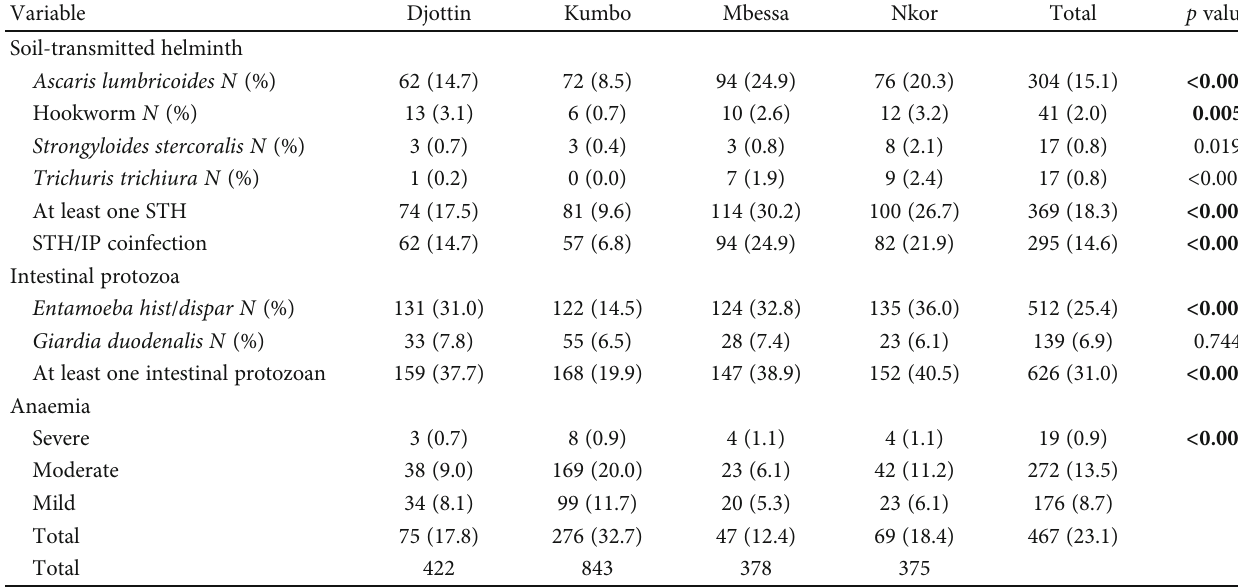
Table 2: Prevalence of intestinal protozoan and STH infections according to the surveyed localities.